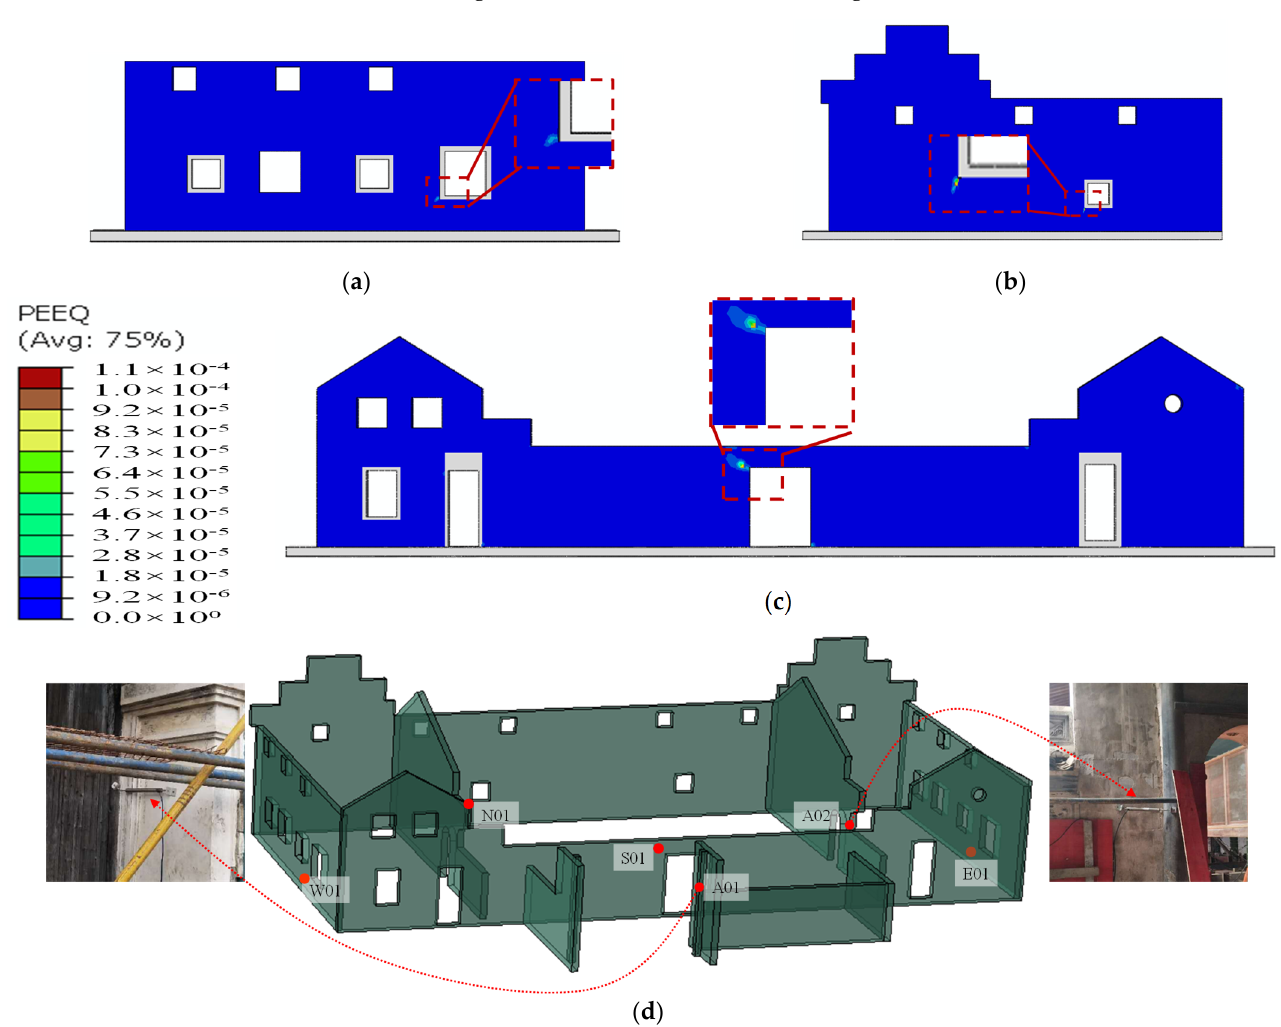
Figure 7. PEEQ distributions of the exterior walls: ( a ) west ( b ) north and ( c ) south sides; ( d ) layout of the displacement transducers. the displacement transducers.